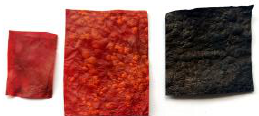
Figure 6. The pieces of material (mGApp50) after the dying